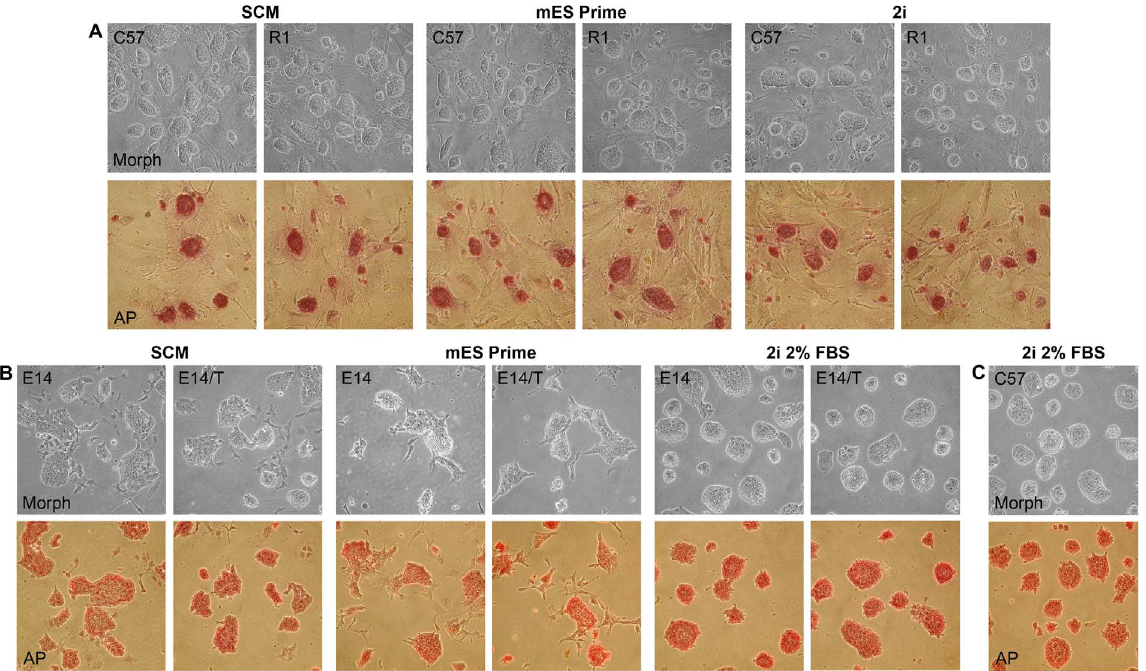
Figure 1. Adherent mouse ES cell colony morphology and alkaline phosphatase activity. Phase-contrast micrographs of colony morphology and alkaline phosphatase activity staining for mES cells grown on feeders (A) and mES cells grown on gelatin (B) for 15 passages in SCM, mES Prime Kit or 2i media. Noteworthy is that the feeder-cell dependent mES cell line C57 was maintained in 2i medium on gelatin for at least 15 passages without showing morphological signs of spontaneous differentiation or loss in alkaline phosphatase activity (C).